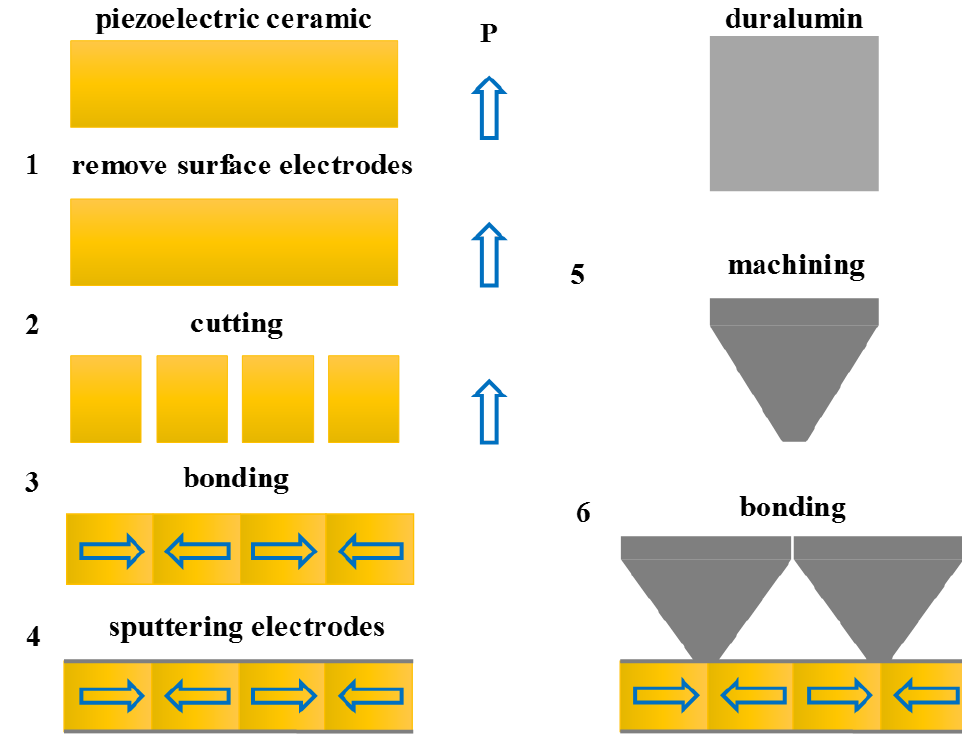
Figure 6. Preparation process of piezoelectric oscillator. Fourteen piezoelectric oscillators were made for the transducer array. Fourteen stain- less steel positioning strips for fixing oscillators were fabricated to arrange oscillators reasonably at an equal distance. Six piezoelectric oscillators were bonded onto the position- ing strip, one-by-one along the transversal direction. The upper and lower surfaces among different oscillators were connected by leads, and electrodes were extended from two ends, thus forming an array element (Figure 7). A total of 14 array elements were prepared. To verify the consistency of array elements, the resonance frequencies and quasi-static capacitances of these elements were measured by an impedance analyzer. Results are shown in Table 3. According to the data in Table 3, the maximum relative deviation of reso- nance frequencies among different array elements was 1.22%, and the maximum relative deviation of quasi-static capacitance was 1.45%. The electrical performance parameters were relatively similar, thus indicating the high consistency of array